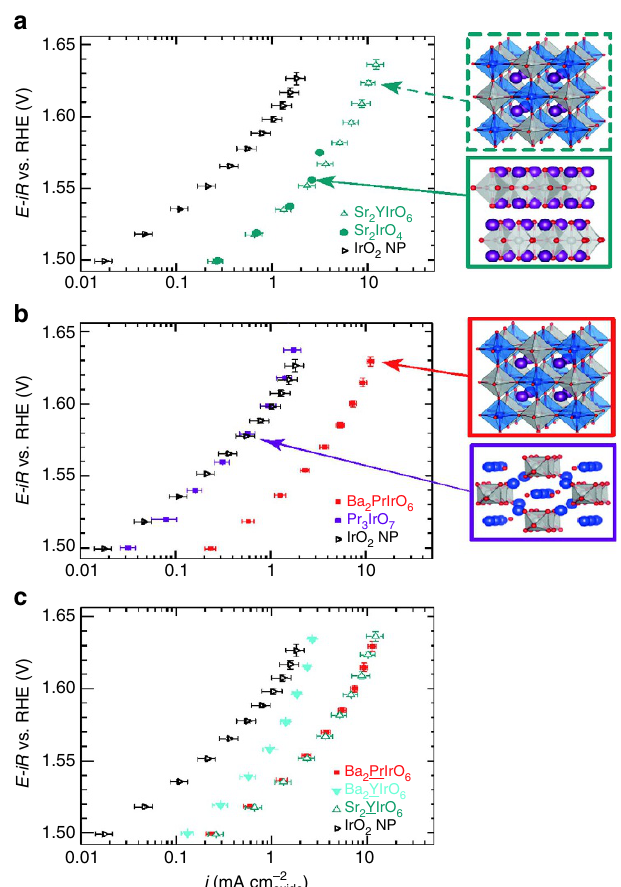
Figure 3 | Structure sensitivity of the OER activity on the double perovskites. ( a ) OER activity in 0.1M HClO 4 of Sr 2 YIrO 6 DP in comparison with Sr 2 IrO 4 . ( b ) OER activity in 0.1M HClO 4 of Ba 2 PrIrO 6 DP in comparison with Pr 3 IrO 7 . ( c ) Effect of the A and B 0 cation substitution on the OER activity in 0.1M HClO 4 of the Ir DPs. The benchmark activity of IrO 2 nanoparticles is shown for comparison. Measurements performed under steady-state conditions. The values in the plot are the average of three independent measurements and the error bars correspond to the